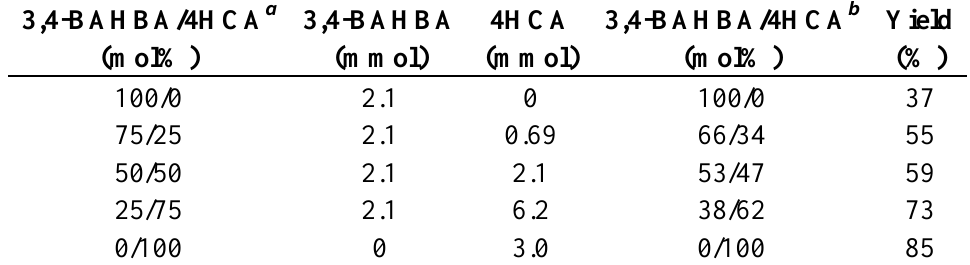
Table 1. Synthesis conditions of Poly(3,4-BAHBA -co-